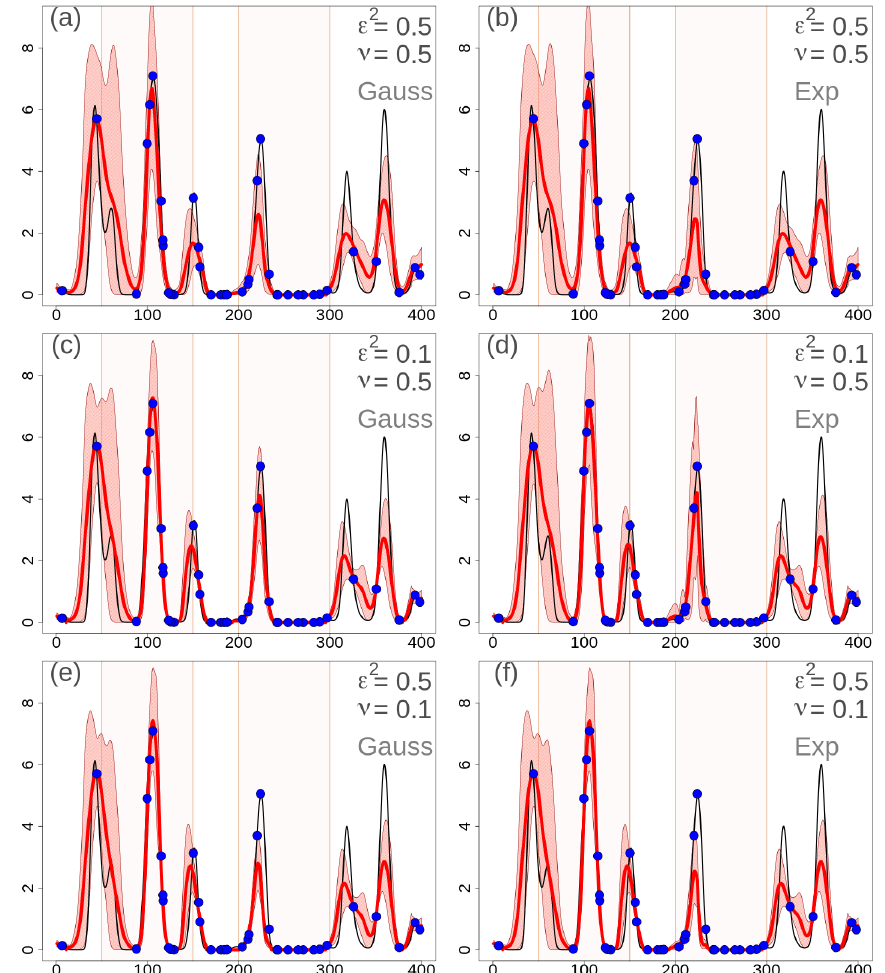
Figure 4. One-dimensional simulation in the original precipitation space (in millimeters). Analyses at grid points with different EnSI-GAP configurations. The layout is the same as in Fig. 3. Table 3. Summary statistics on the evaluation of the 100 one-dimensional simulations. Results are presented for three modes, namely EnSI- GAP, no transformation, which is EnSI-GAP without applying the Gaussian anamorphosis, and no ensemble, which is EnSI-GAP where the background is the ensemble mean, and the background error covariance matrix is determined solely by the scale matrix. The configurations listed are the same as those that have been used in Figs. 3–6, and the abbreviations have the same meanings (e.g., with reference to Fig. 3, the first row corresponds to (a) , the second to (b) , and so on). The mean squared error skill score (MSESS; Eq. 23) is positively oriented, with a perfect score being one. The continuous ranked probability score ( CRPS; Eq. 24) is negatively oriented, with a perfect score being zero. For each configuration and score, the best values are marked in bold. Note: exp – exponential